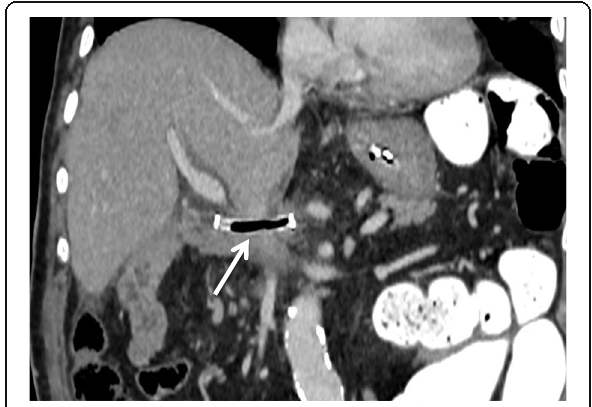
Fig. 2 Enhanced CT on POD 85. CT reveals the presence of air within the occluded stent graft, which indicates stent graft infection